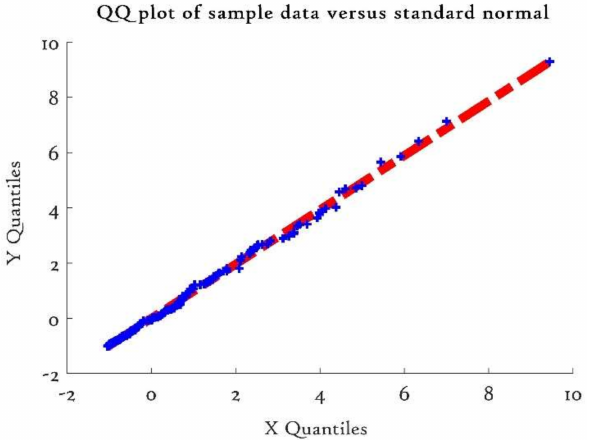
Figure 18. QQ plot for GP blade pitch